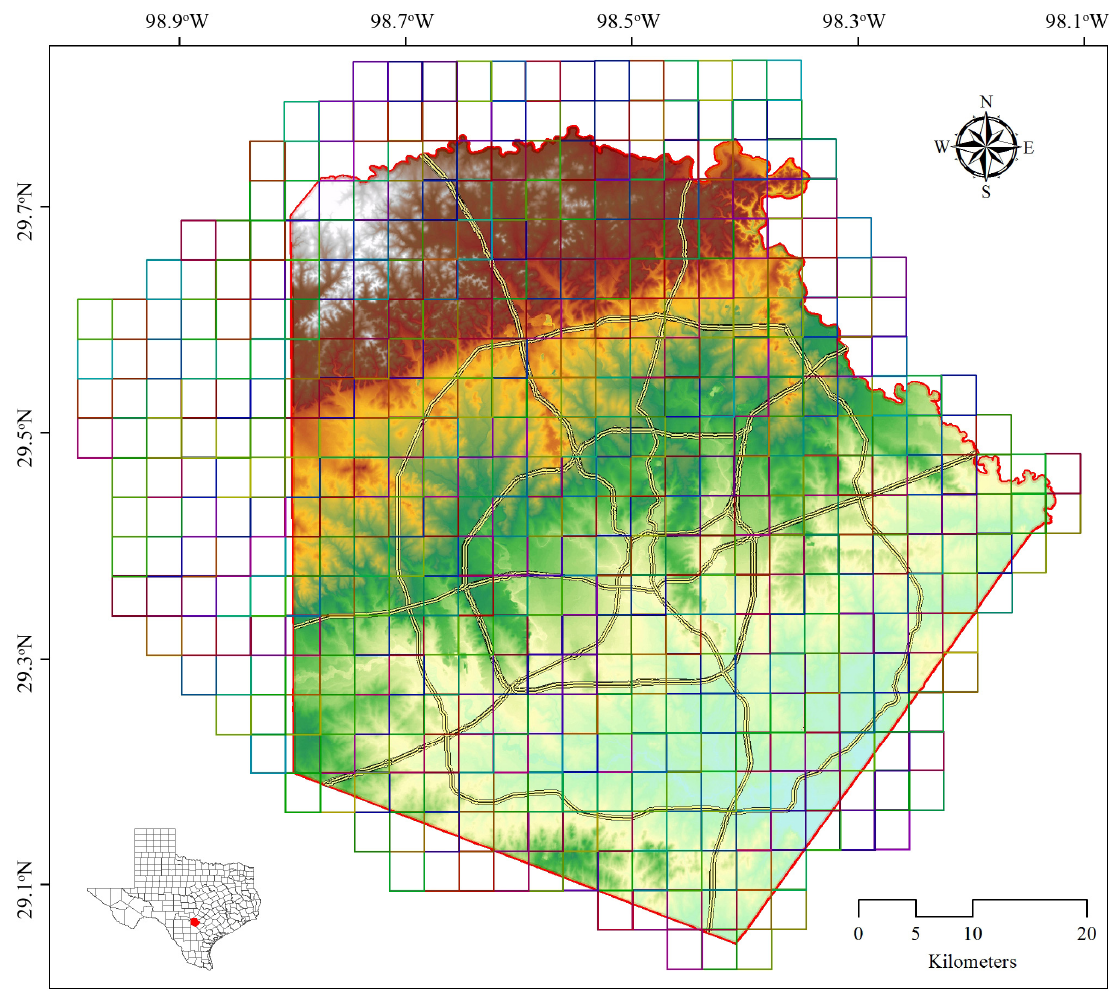
Figure 1. 458 LiDAR titles over the San Antonio (Bexar County), Texas area, overlaying with major highways.